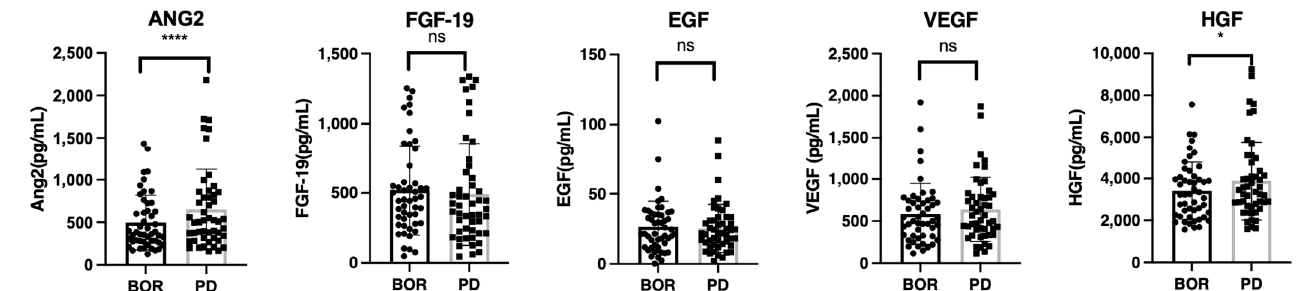
Figure 3. The changes in growth factors between the best response and progressive disease points in patients with SD, PR, and CR. Serum median FGF-19, ANG-2, HGF, EGF, and VEGF levels were compared between the best response and progressive disease points in patients with SD, PR, and CR. Asterisks indicate statistically significant differences (* p < 0.05, **** p < 0.0001, ns: not significant). BOR, best response; SD, stable disease; PR, partial response; CR, complete response.